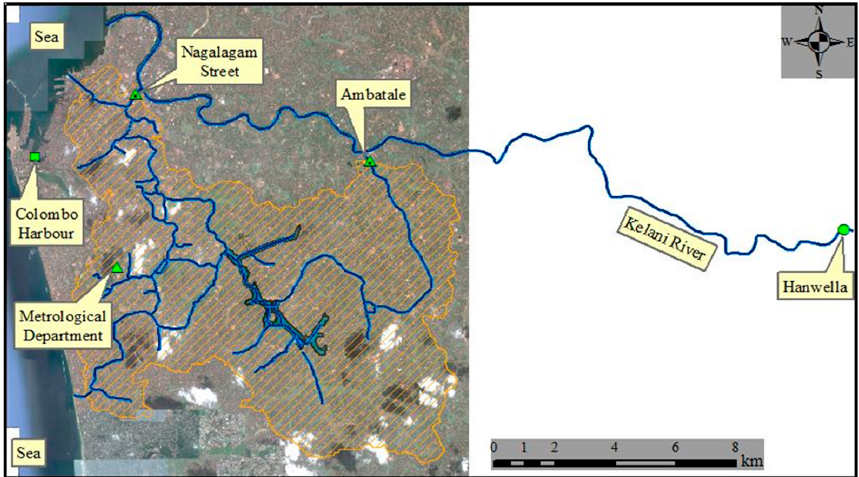
Figure 4. Locations of the rainfall gauge (Sri Lanka Metrological Department), sea tide gauge (Colombo harbour), water level and discharge gauging stations (Kelani River).